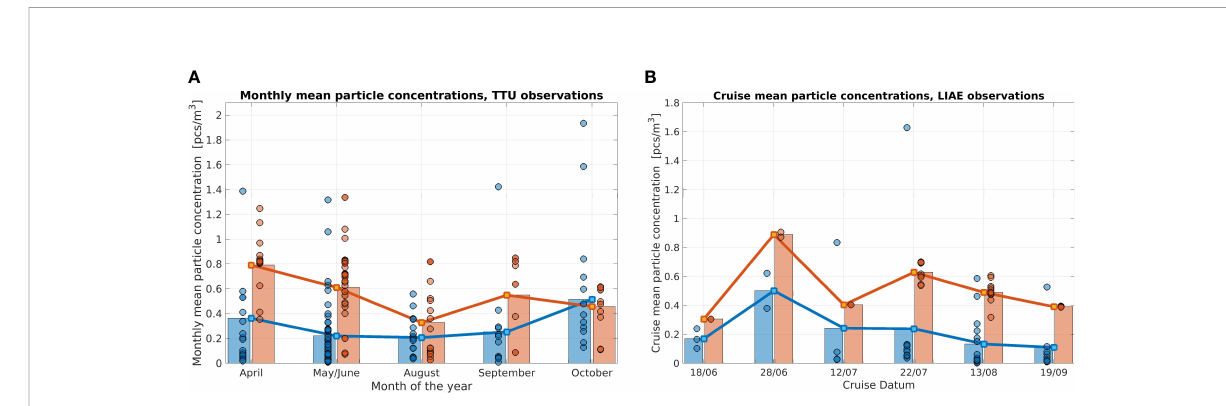
FIGURE 11 Comparison of observed (blue) and modeled (red) data sets from TalTech in Estonia (A) and from LIAE in Latvia (B) . Monthly averages (left) and cruise averages (right) are shown as solid lines and bars, whereas individual observations and model data points are presented as red and blue